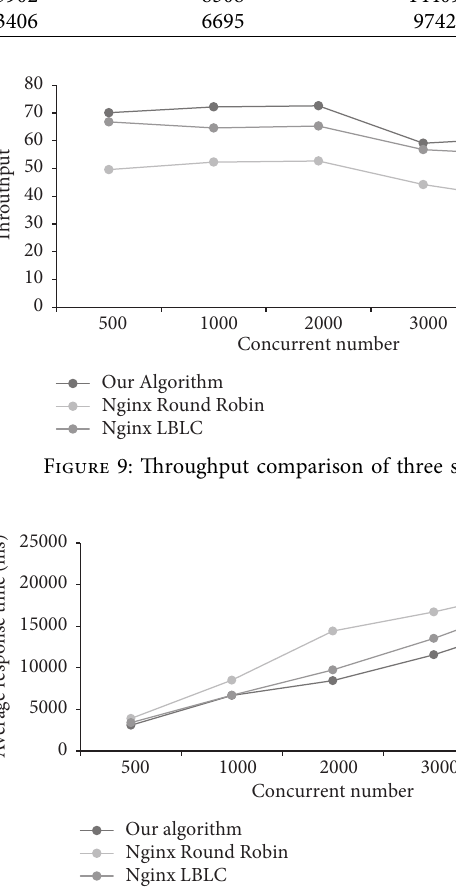
Figure 10: Average response time comparison of three